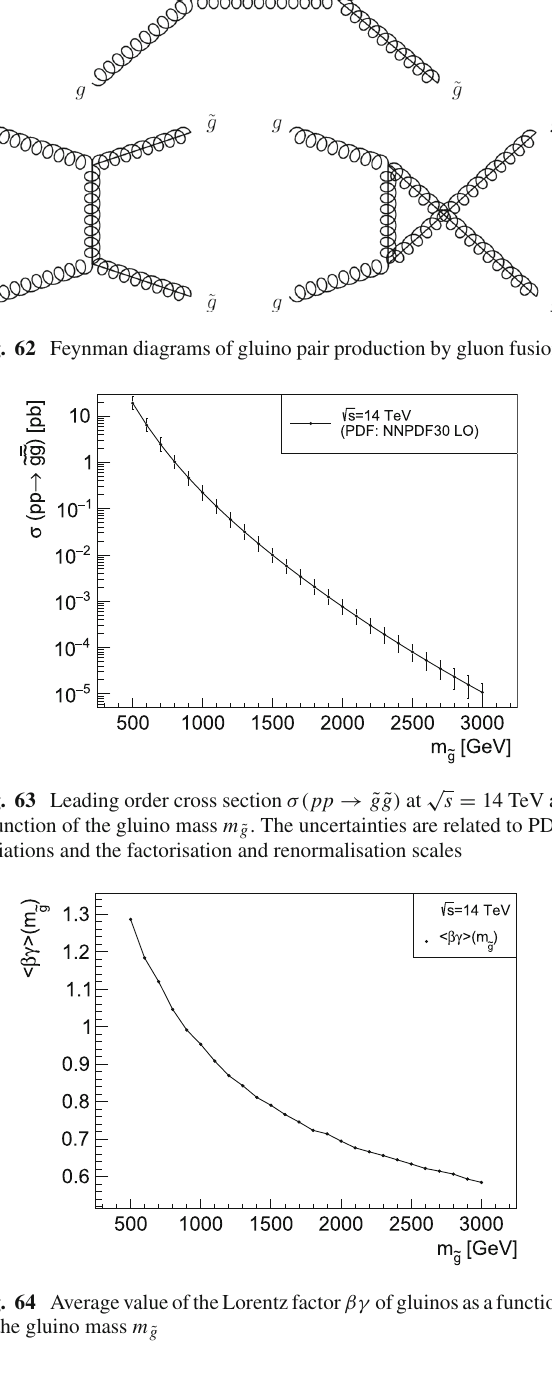
are not taken into account in this study. Therefore, the gluino decay width (and the gluino flight distance) depends on three masses (the gluino mass, the stop mass, the neutralino mass) and the nature of the neutralino, i.e., bino, wino or (up-like only) higgsino. Figures65 and 66 illustrate this dependence.